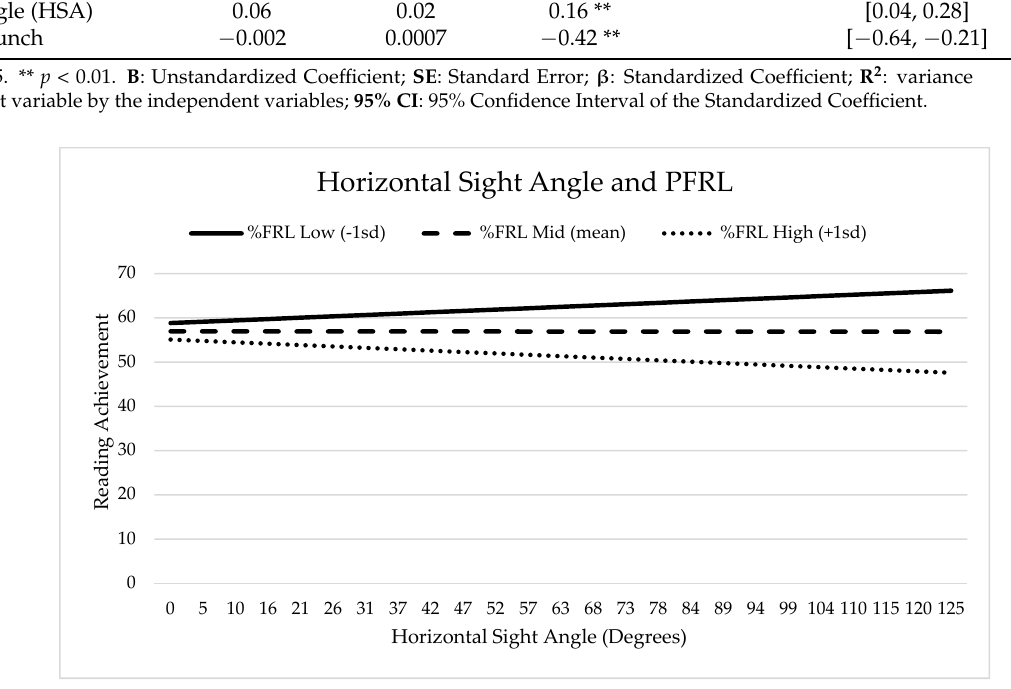
Figure 4. Interaction Plot for Horizontal Sight Angle and % Free and Reduced Lunch Students on Reading Achievement. Table 4 . Multivariate Regression of Math Achievement on Demographics and Lighting Metrics.